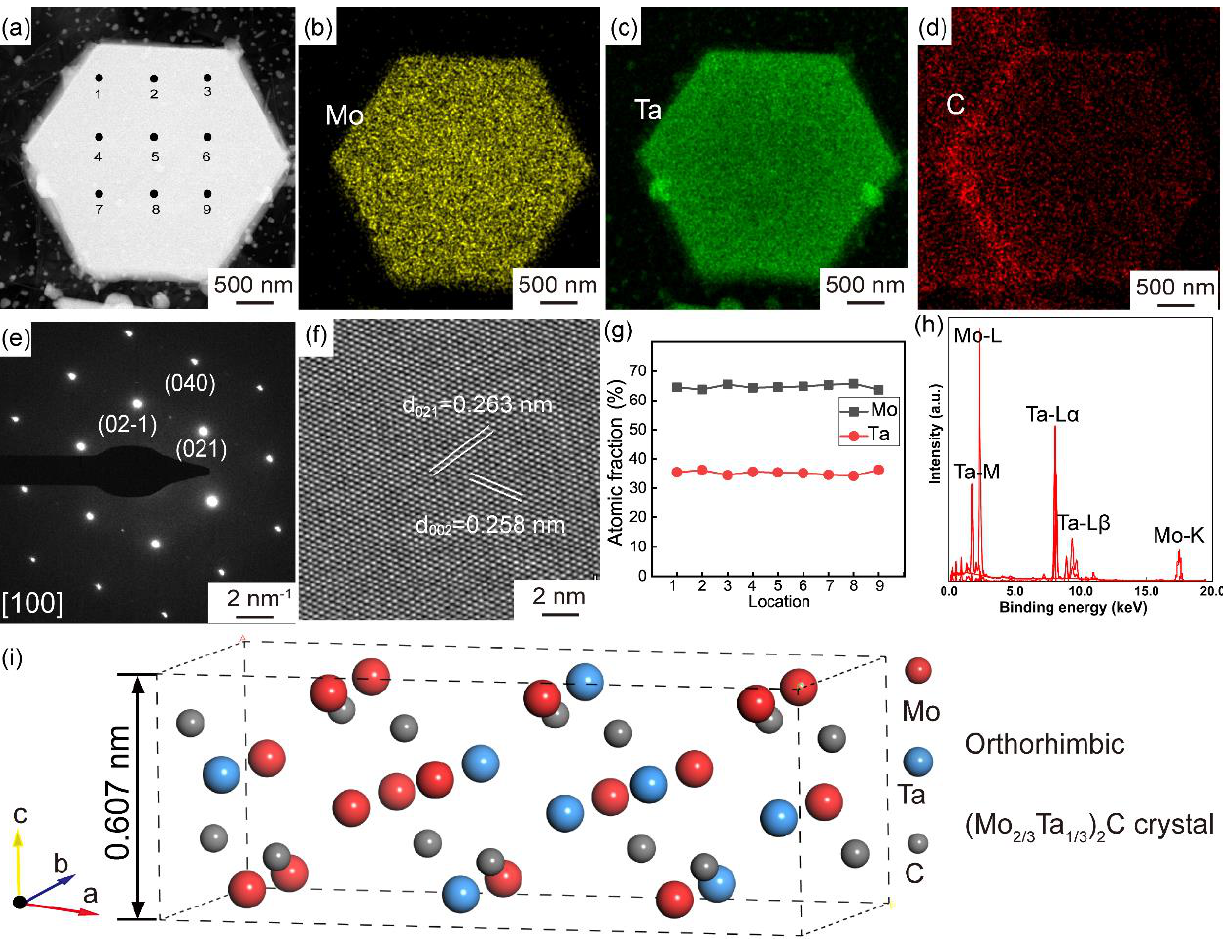
Figure 2. TEM images of polygonal MTC crystal ( a ) and corresponding EDS elemental mapping of Mo ( b ), Ta ( c ), and C ( d ). SAED pattern along [100] zone axis ( e ) and HRTEM image of a polygonal crystal ( f ). Atomic fraction of Mo and Ta in the polygonal crystal of ( a ). ( g ) Based on EDS spectrum ( h ). ( i ) Crystallographic structure of orthorhombic (Mo 2/3 Ta 1/3 )C.